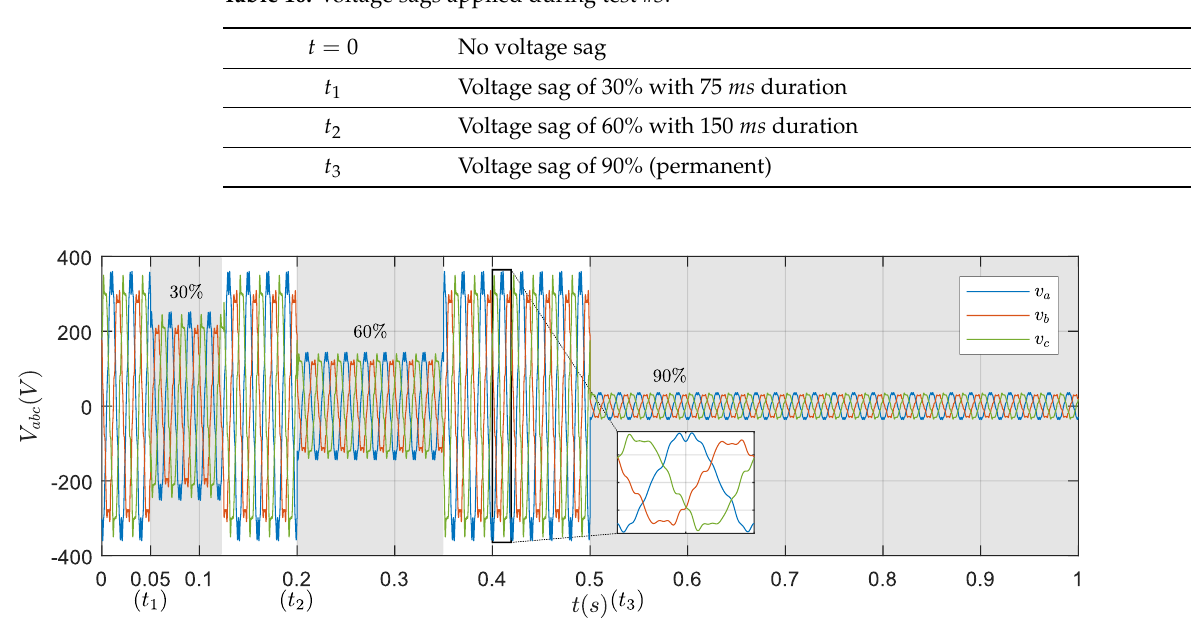
Figure 15. Voltage sags applied during test